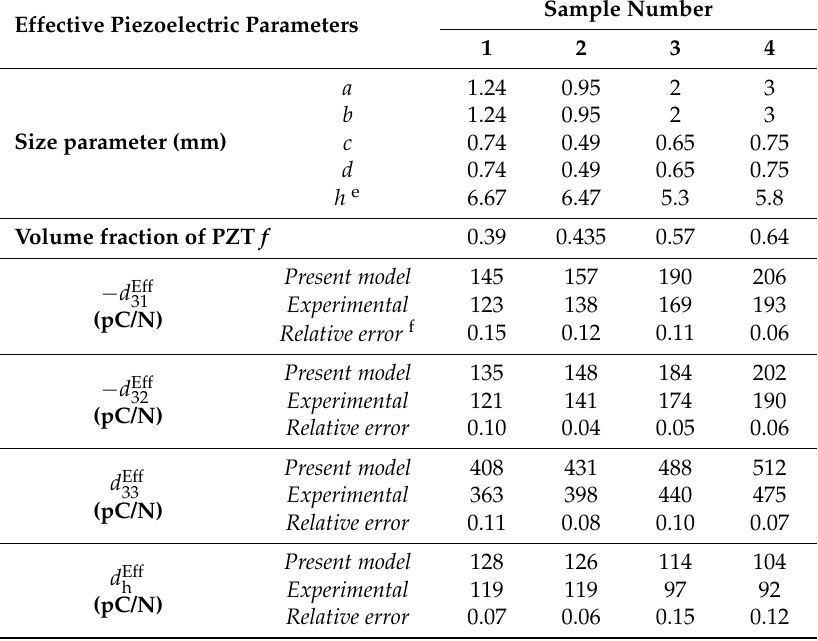
Table 2. Comparison between theoretical and experimental values of the piezoelectric strain coefficients. Effective Piezoelectric